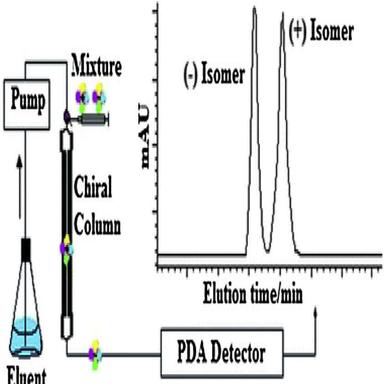
Schematic of chromatography based chiral separation .